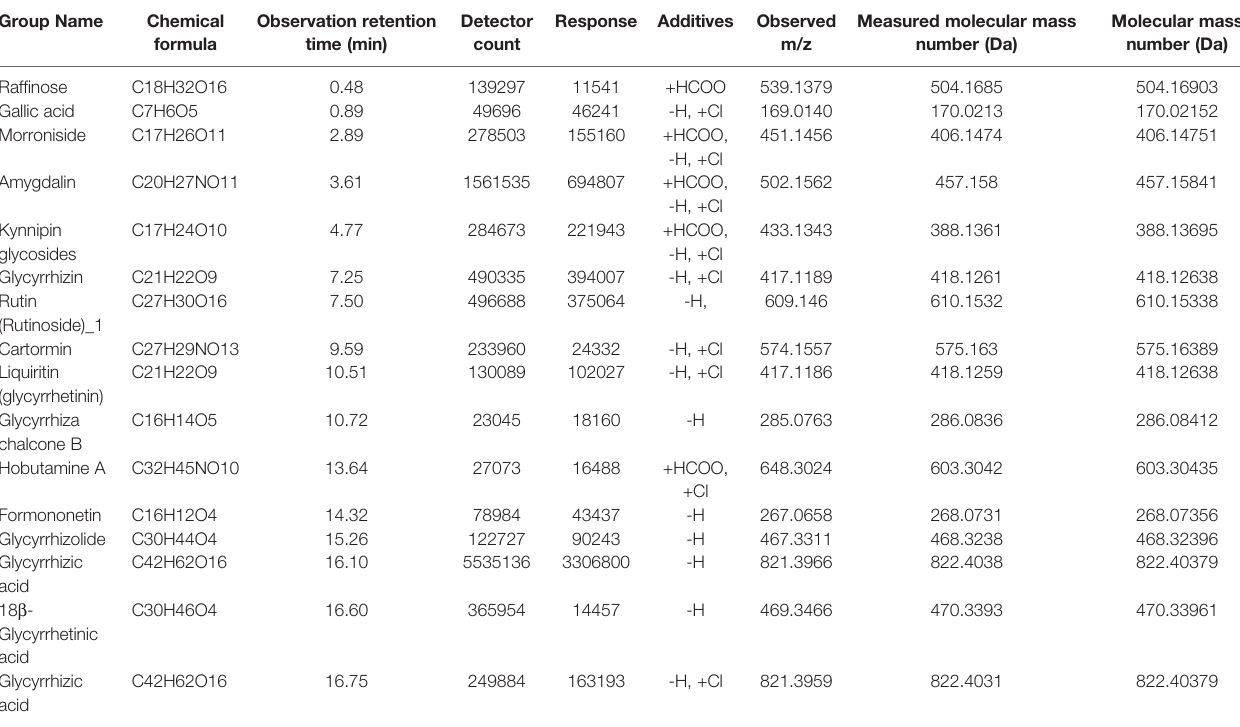
TABLE 2 | The detailed information of compounds contained in MYGY-Nb.